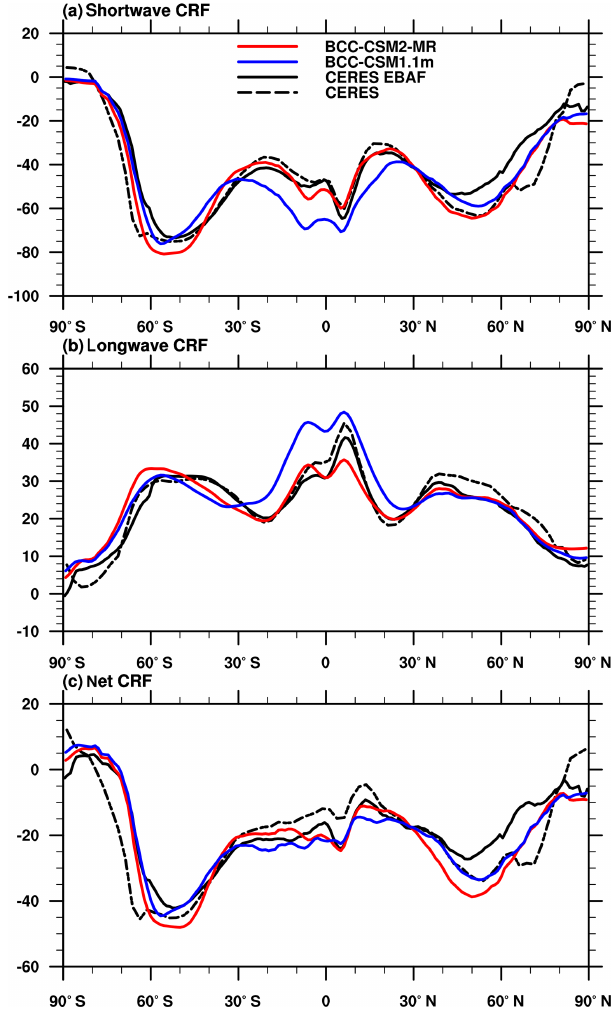
Figure 3. Zonal averages of the cloud radiative forcing (CRF) from the BCC CMIP5 and CMIP6 models and the observations (in Wm − 2 ; a : shortwave effect; b : longwave effect; c : net effect). Model results are for the 1986–2005 period, whereas the available CERES ES-4 and CERES-EBAF 2.6 data set are for the 2003–2014 period.